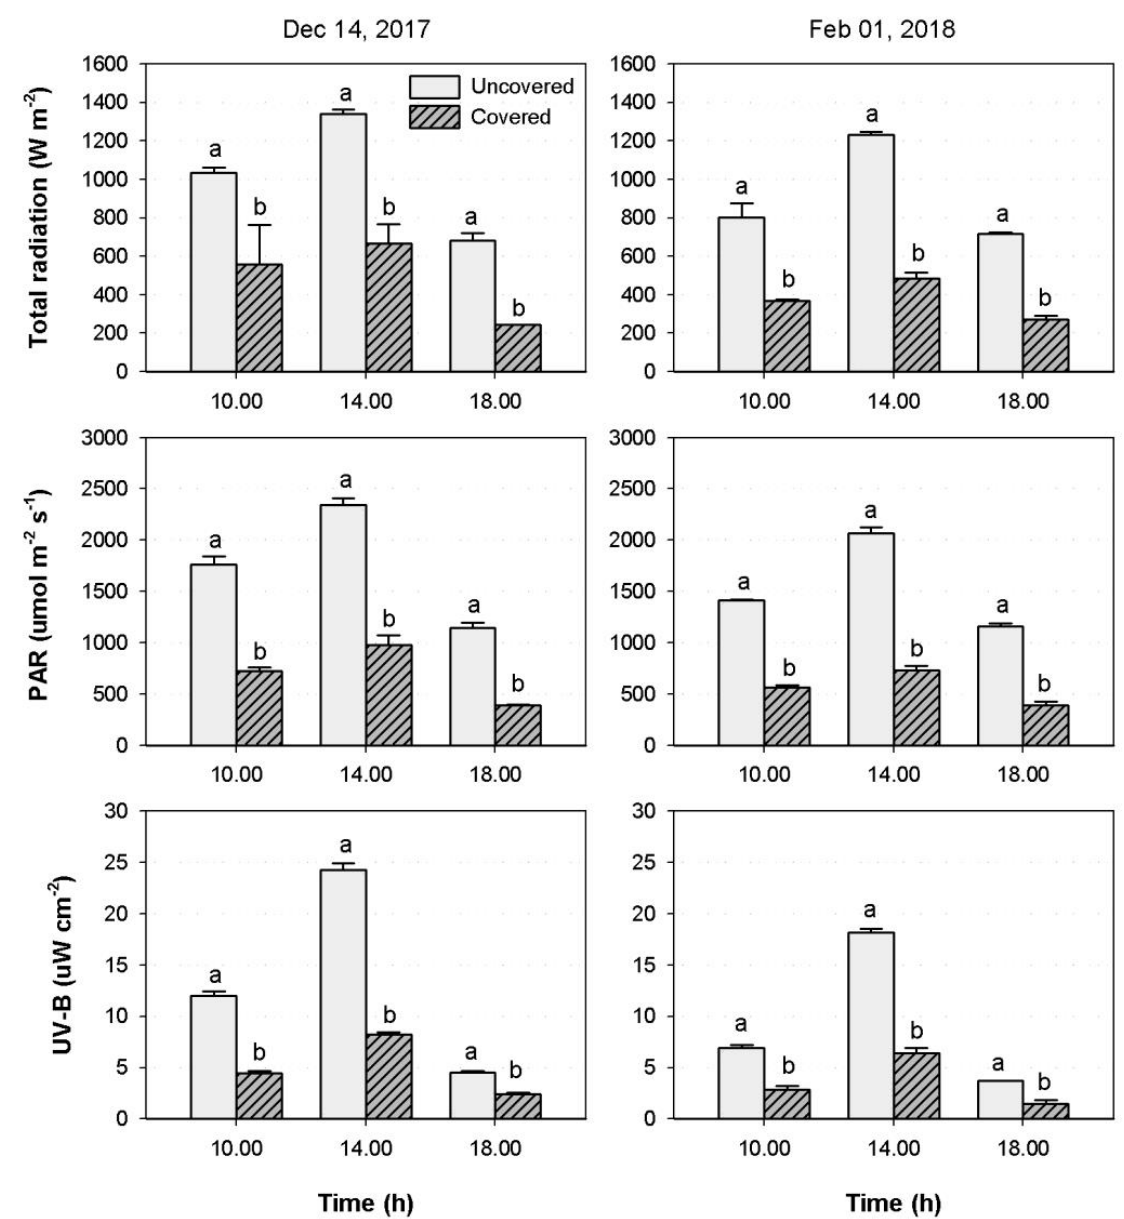
Figure 1. Total solar, photosynthetically active (PAR) and ultraviolet B (UV-B) radiation with and without rain cover at three times of the day on 14 December 2017 and 1 February 2018. Columns followed by the same letters indicate no statistical difference between treatments according to the Tukey test ( p ≤ 0.05). Means + SE ( n = 5). Central Valley, Chile. The rain cover affected the air temperature to a greater extent in the area closest to it, reaching its maximum earlier than in the uncovered treatment and for a longer period of time, while the measurements at 1.5 m did not show major differences, with the minimum temperatures being warmer under the rain cover (Figure